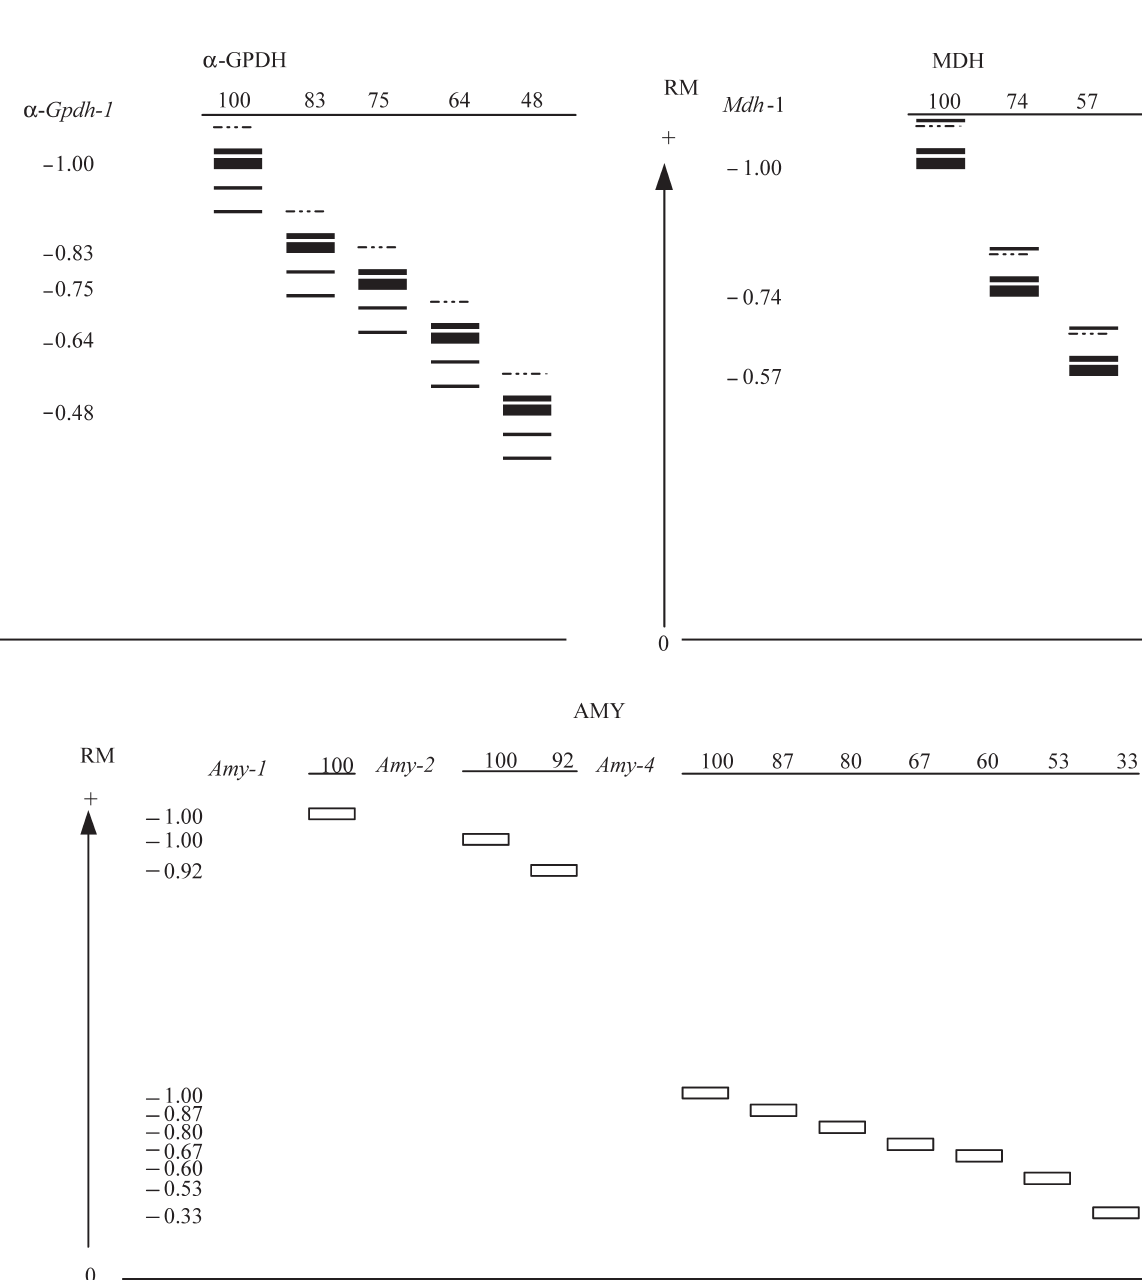
Figure1 -Electrophoreticpatternofmalatedehydrogenase(MDH), α -glycerophosphatedehydrogenase( α -GPDH)andamylase(AMY)in Acromyrmex heyeri and Acromyrmex striatus . The gene locus and its alleles are indicated at the top of each pattern and the relative migration (RM) of each primary isoenzyme is shown on the